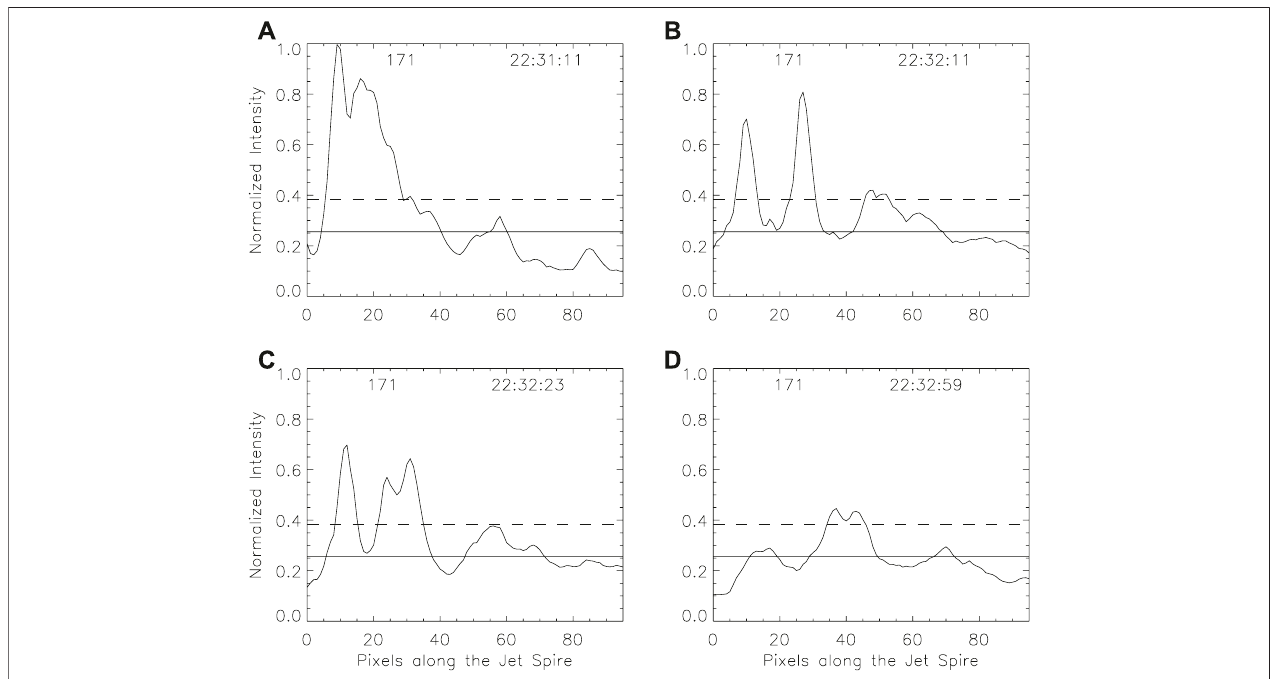
FIGURE 7 | Intensity pro fi les along the spine of the jet in Figure 2B . We select the region which is marked with a white rectangle in Figure 2B to calculate the total intensity of the jet spine. The different curve indicates the normalized intensity along the jet spine at different moments, (A) 22:31:11, (B) 22:32:11, (C) 22:32:23, (D) 22: 32:59,